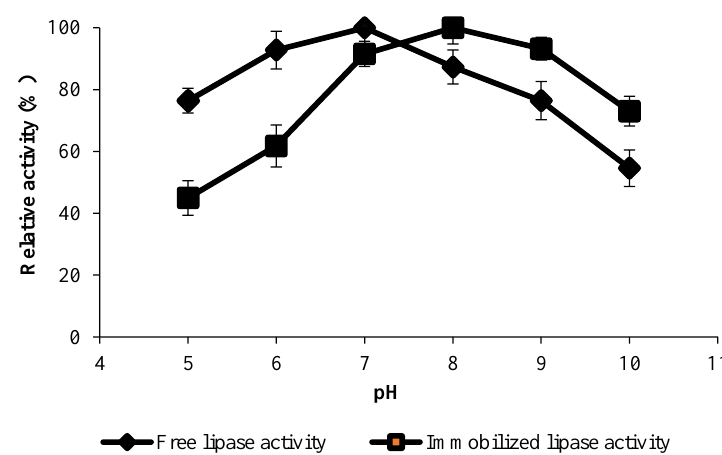
Figure 5. Effect of pH on the activities of free and immobilized lipase (date points are the mean of triplicate reaction values).